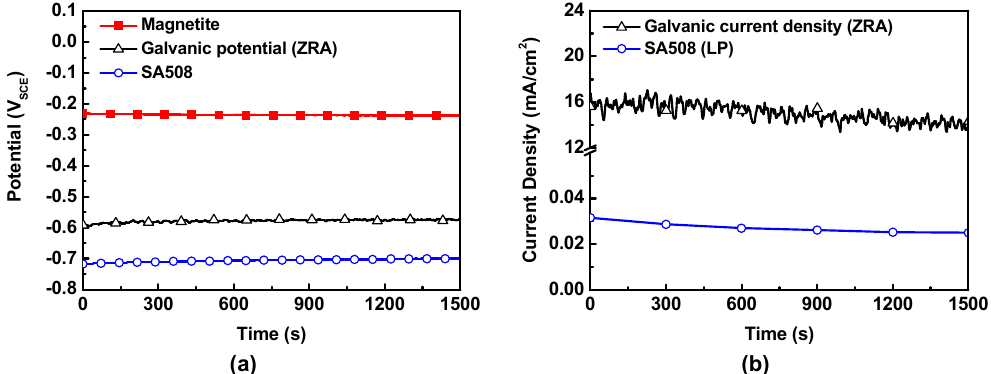
Figure 7. Effect of magnetite on: ( a ) the corrosion potential; and ( b ) corrosion current density in 10% EDTA-based solution at 93 °C.